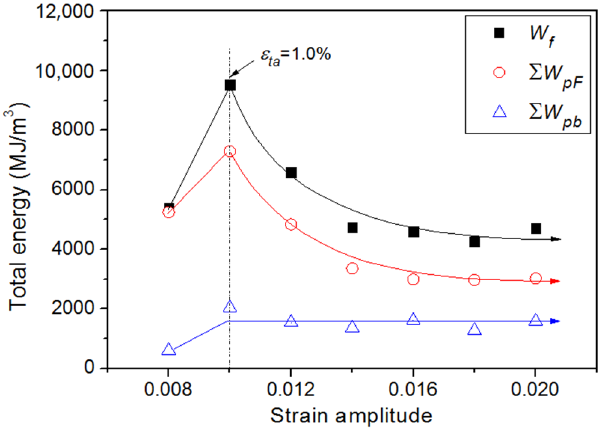
Figure 14. Total energy densities to failure.